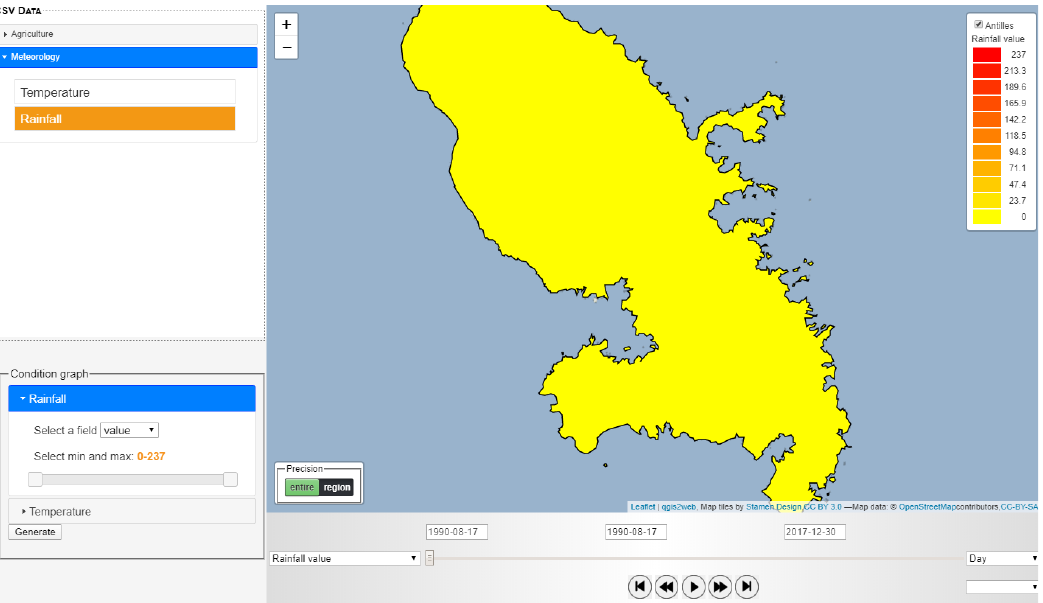
Figure 4. Visualization of spatiotemporal data (simulation) and resources available into DKP